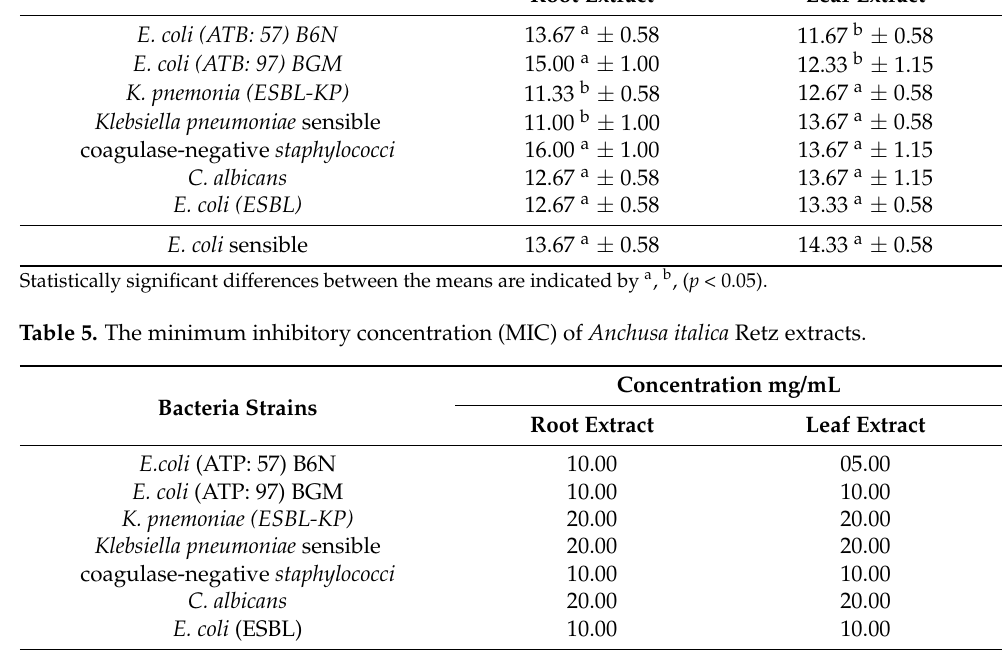
Table 4. Diameter of inhibition zones of Anchusa italica Retz extracts. Bacteria Strains